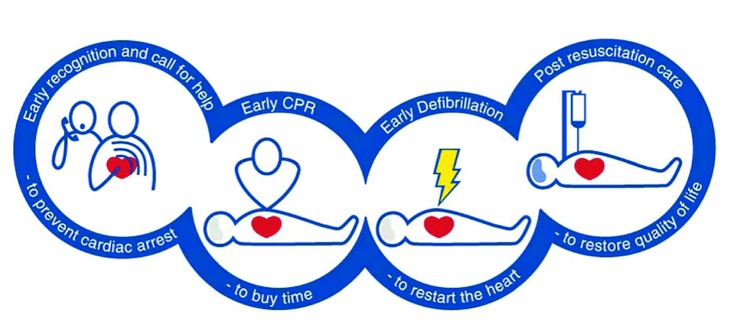
Chain of survival.